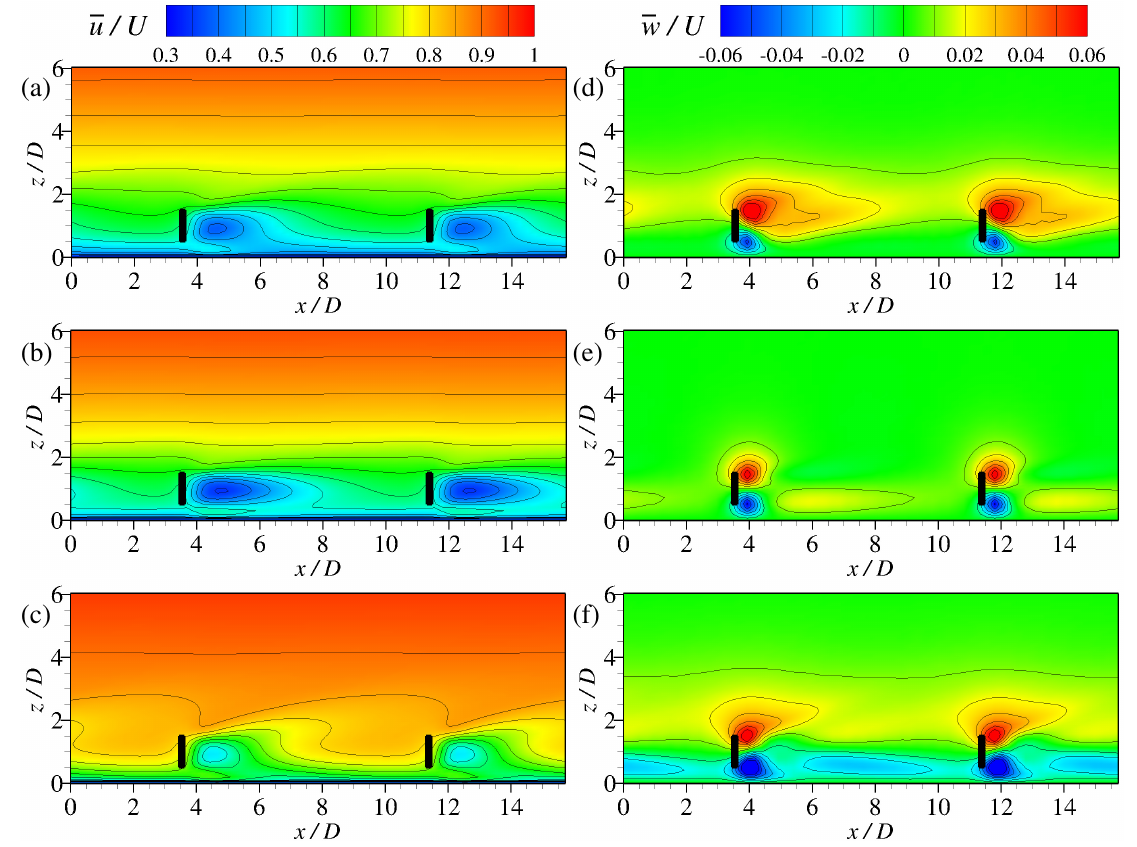
Figure 7. Contours of ( a – c ) time-averaged streamwise velocity and ( d – f ) time-averaged vertical velocity are shown on an xz -plane that bisects one column of turbines for: ( a , d ) A = − 1; ( b , e ) A = 0; and ( c , f ) A = 1. Only two of the four turbines in the column are shown for each case. The direction of flow is from left to